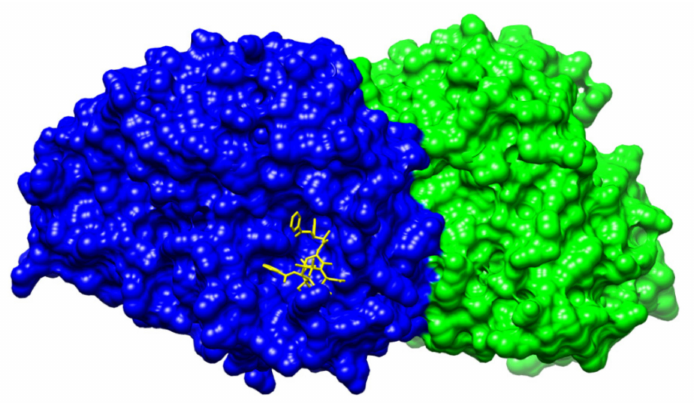
Figure 7. The binding site of paclitaxel on tubulin dimer, PDB (Protein Data Bank) structure 1jff adapted by Chimera